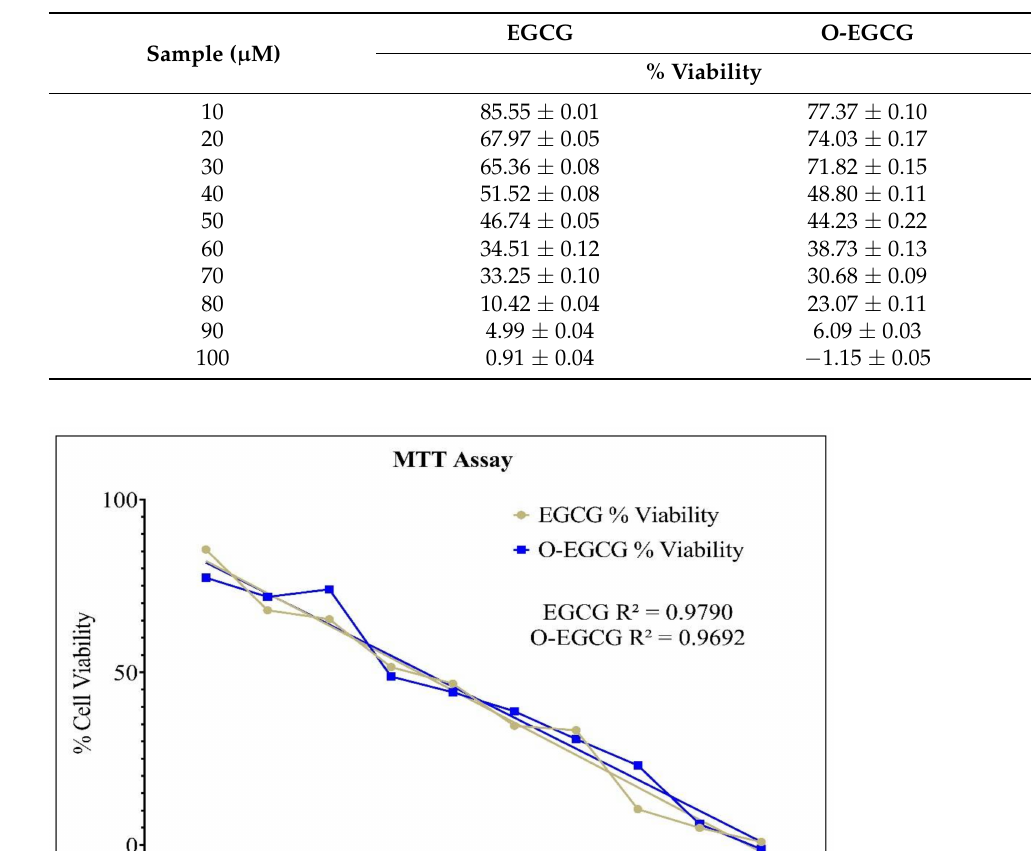
Table 1. MTT assay of EGCG and O-EGCG on HCT-116 cells.